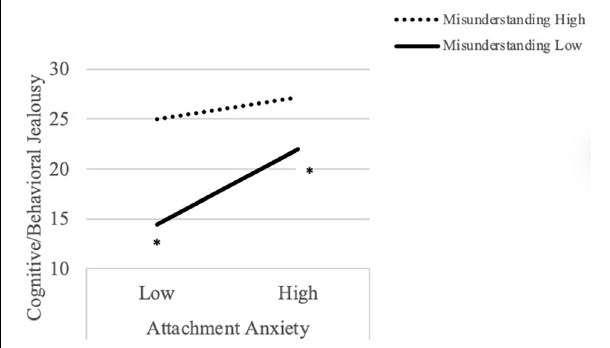
FIGURE 2 | Attachment style and apprehension about communicating online interact to predict emotional